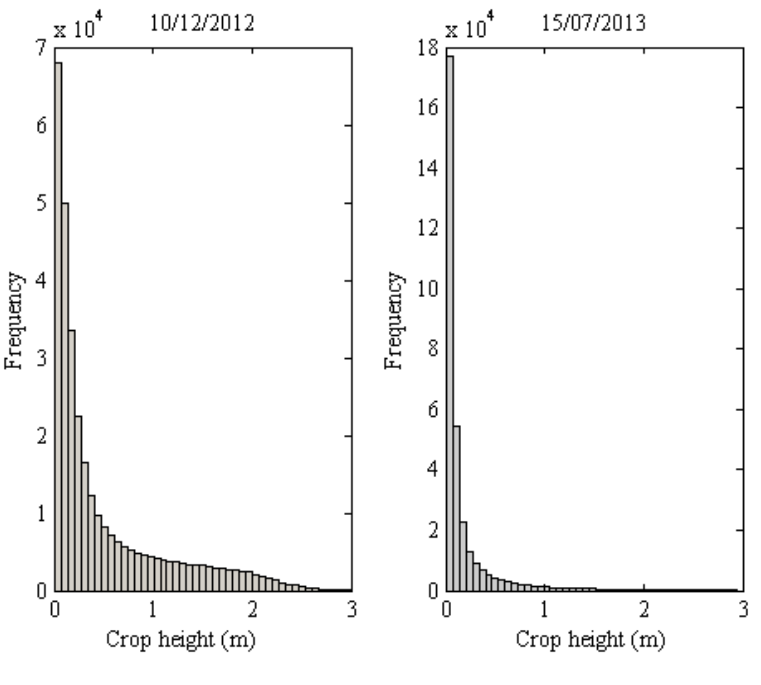
Figure 10. Spatial variability (absolute frequency) of h summer (15 July 2013) in Sidi